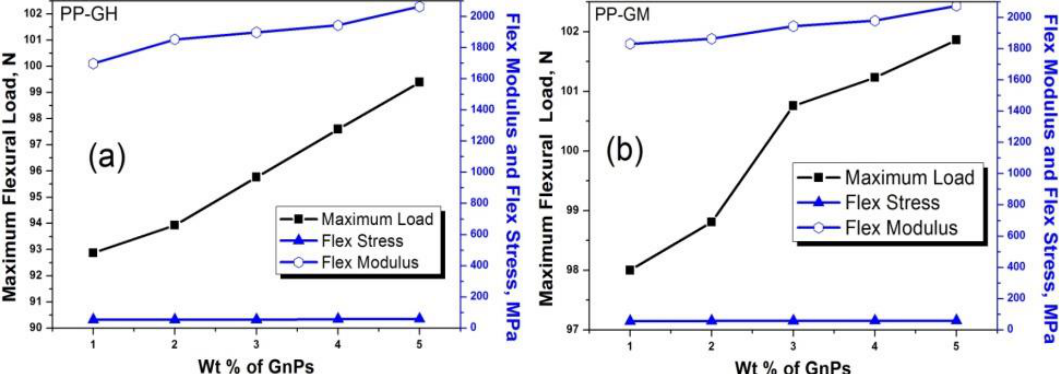
Figure 4. Flexural Strength, flexural modulus and maximum flexural load of ( a ) PP-GH and ( b ) PP-GM nanocomposites.